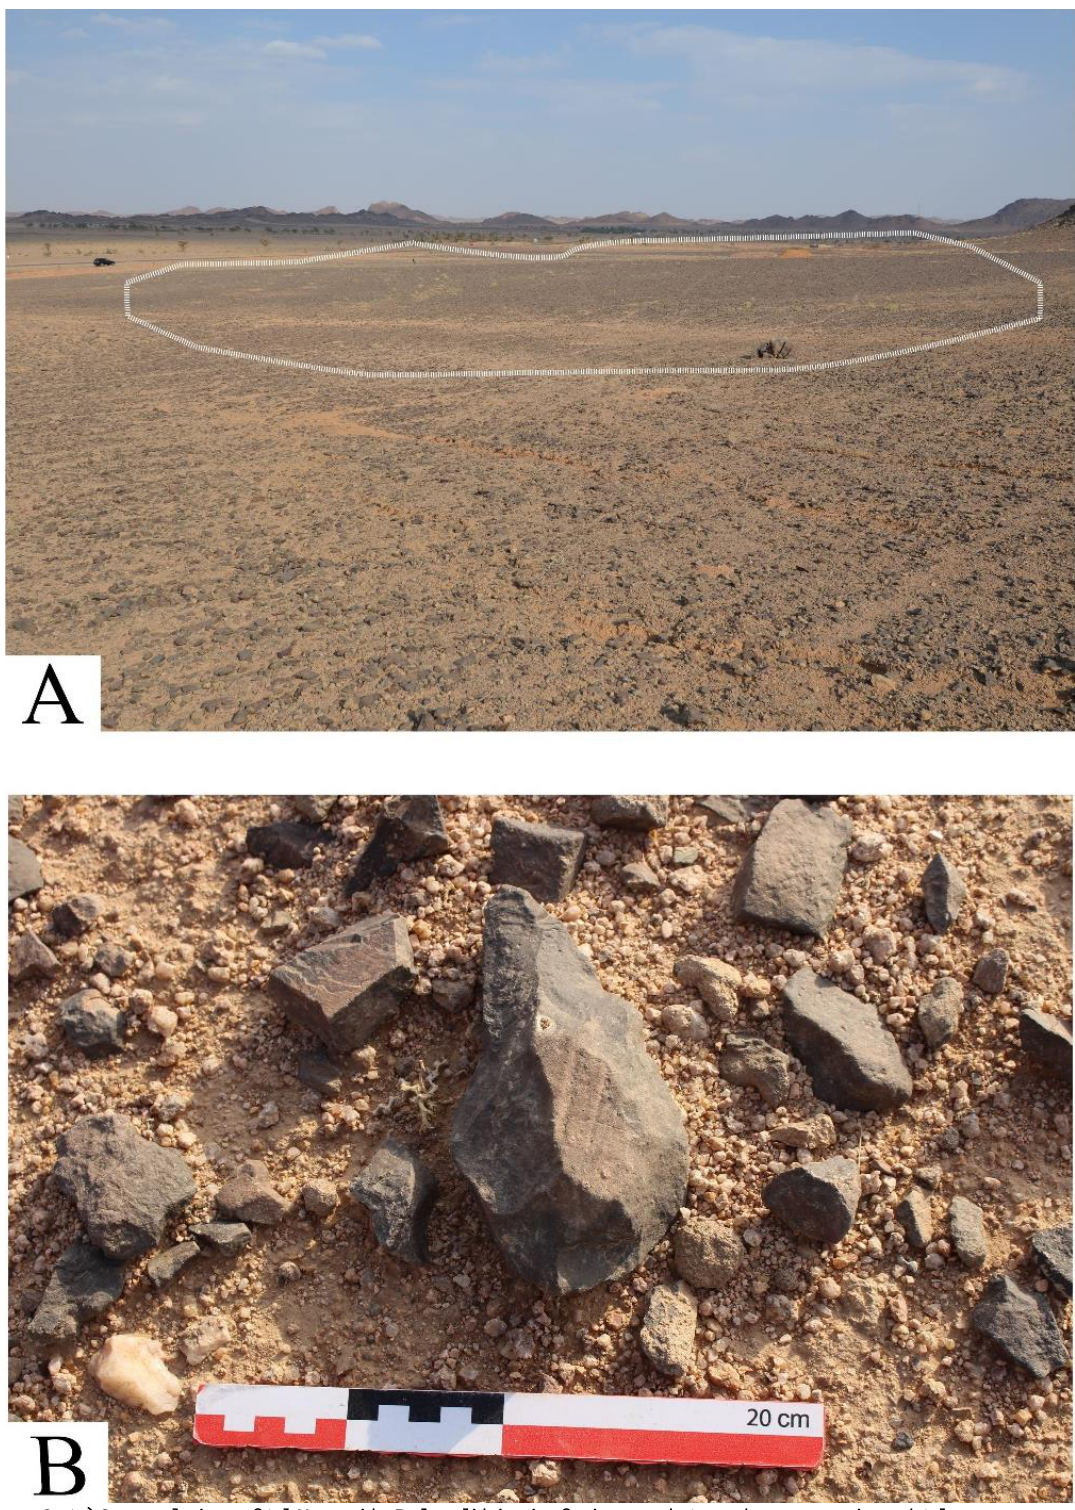
Figure 3: A) General view of Al-Huwaidy Palaeolithic site facing south Amodan mountain and Alsamra mountain on the right, west of the site. B) Handaxe accumulated on the